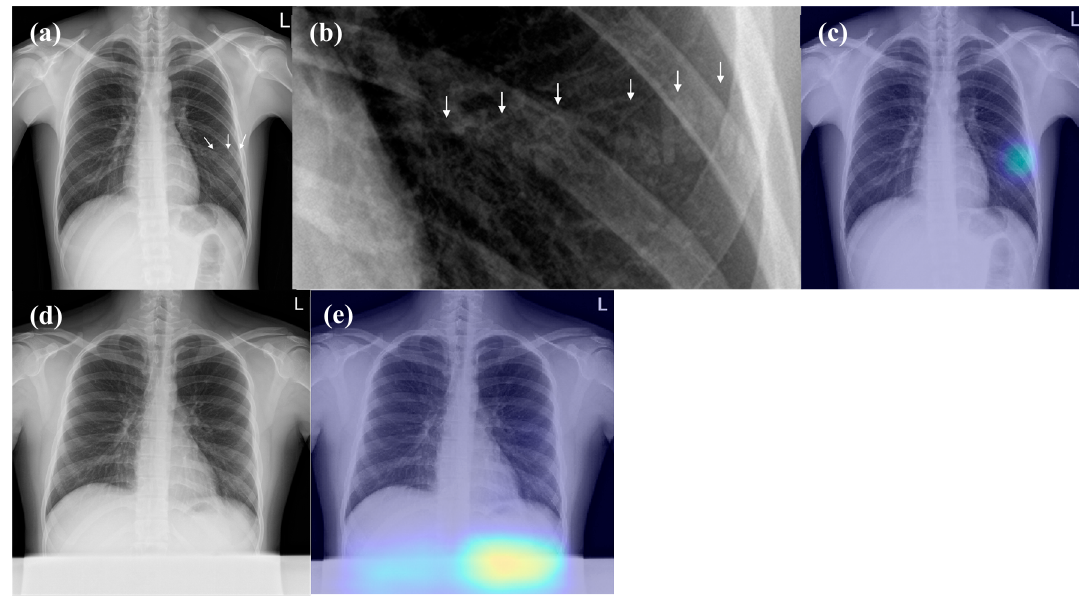
Figure 5. False positive interpretations of the DL algorithm. ( a , b ) The CR shows radio-opaque letters “ROK ARMY” (arrows) of the shirt at the left middle lung field. ( c ) The DL algorithm wrongly localised the radio-opaque letters (probability score, 0.348). ( d ) There is an accidentally included abdominal shield at the lower part of the CR. ( e ) The DL algorithm wrongly detected the abdominal shield (probability score, 0.684). None of the three observers identified these foreign bodies as lesions.